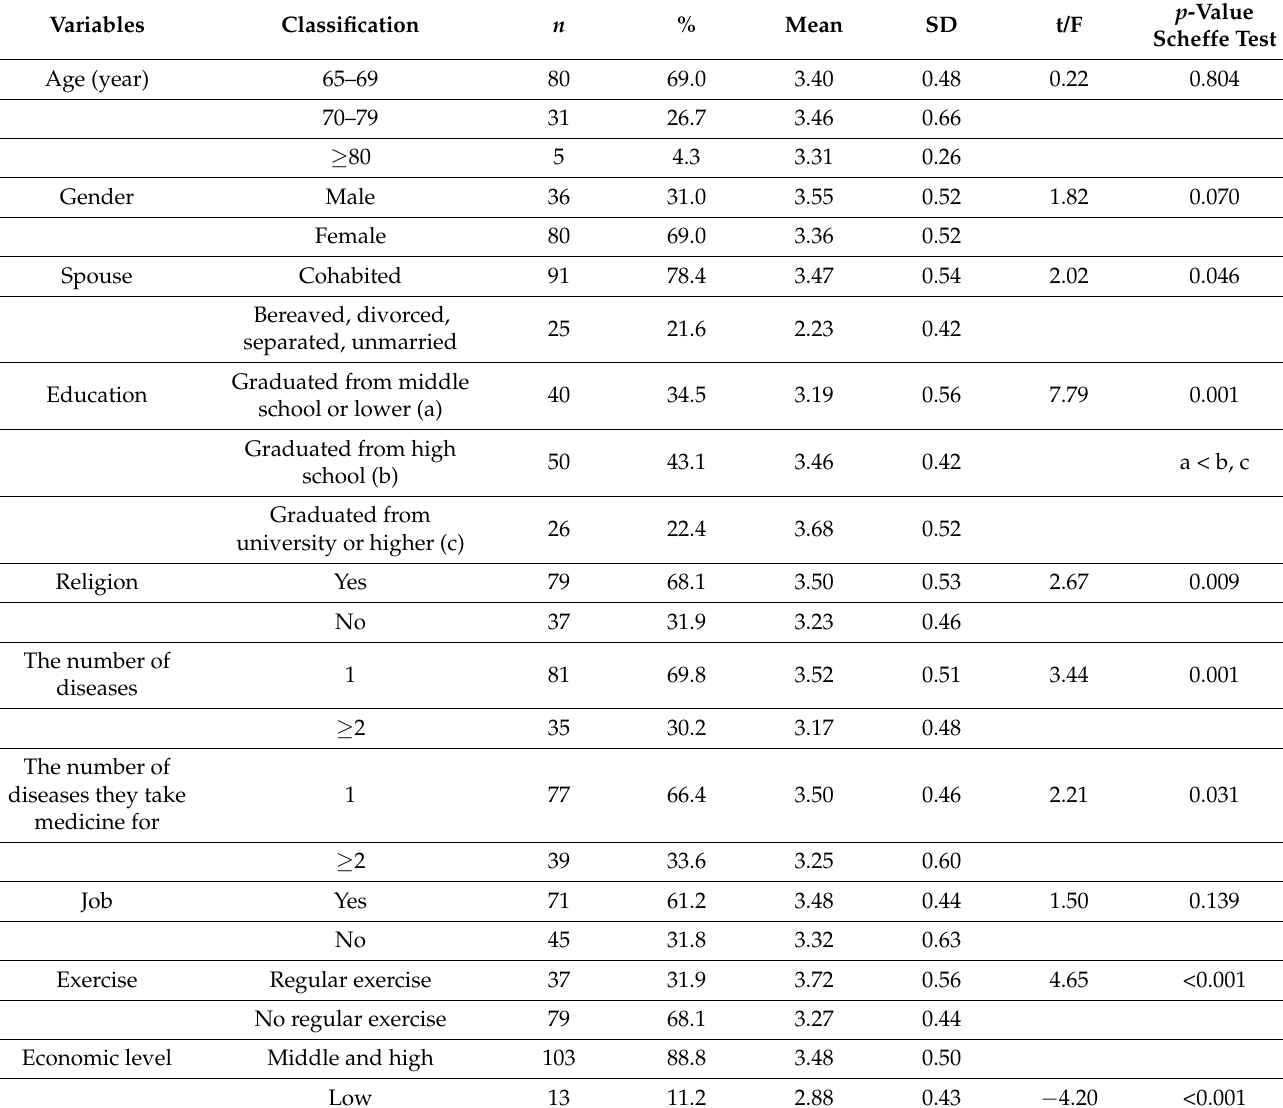
Table 1. Differences in healthy aging according to general